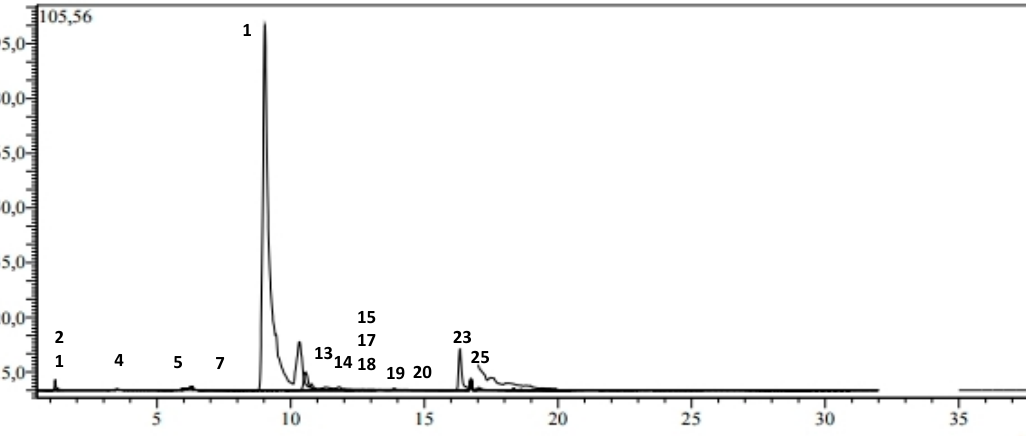
Figure 3. LC-MS / MS chromatogram of EA extract of H. laevigata var. hipponensis .